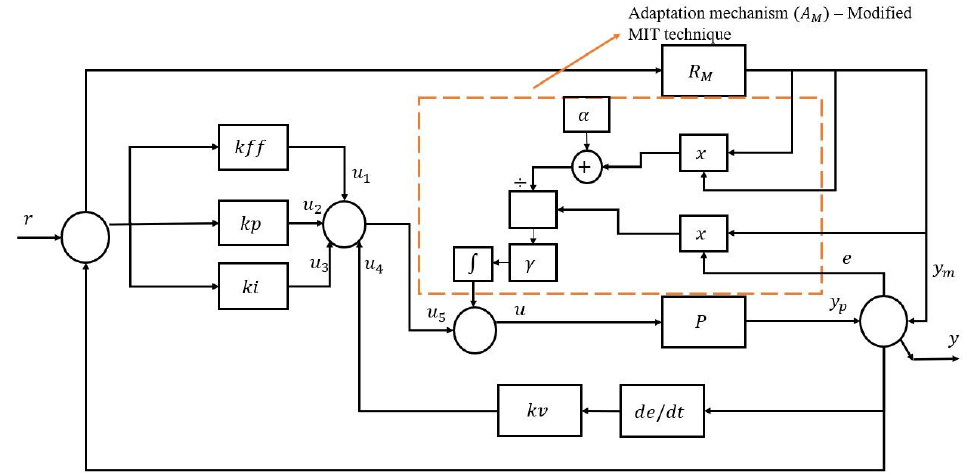
Figure 3. Enhanced Model Reference Adaptive Control (EMRAC) Scheme.